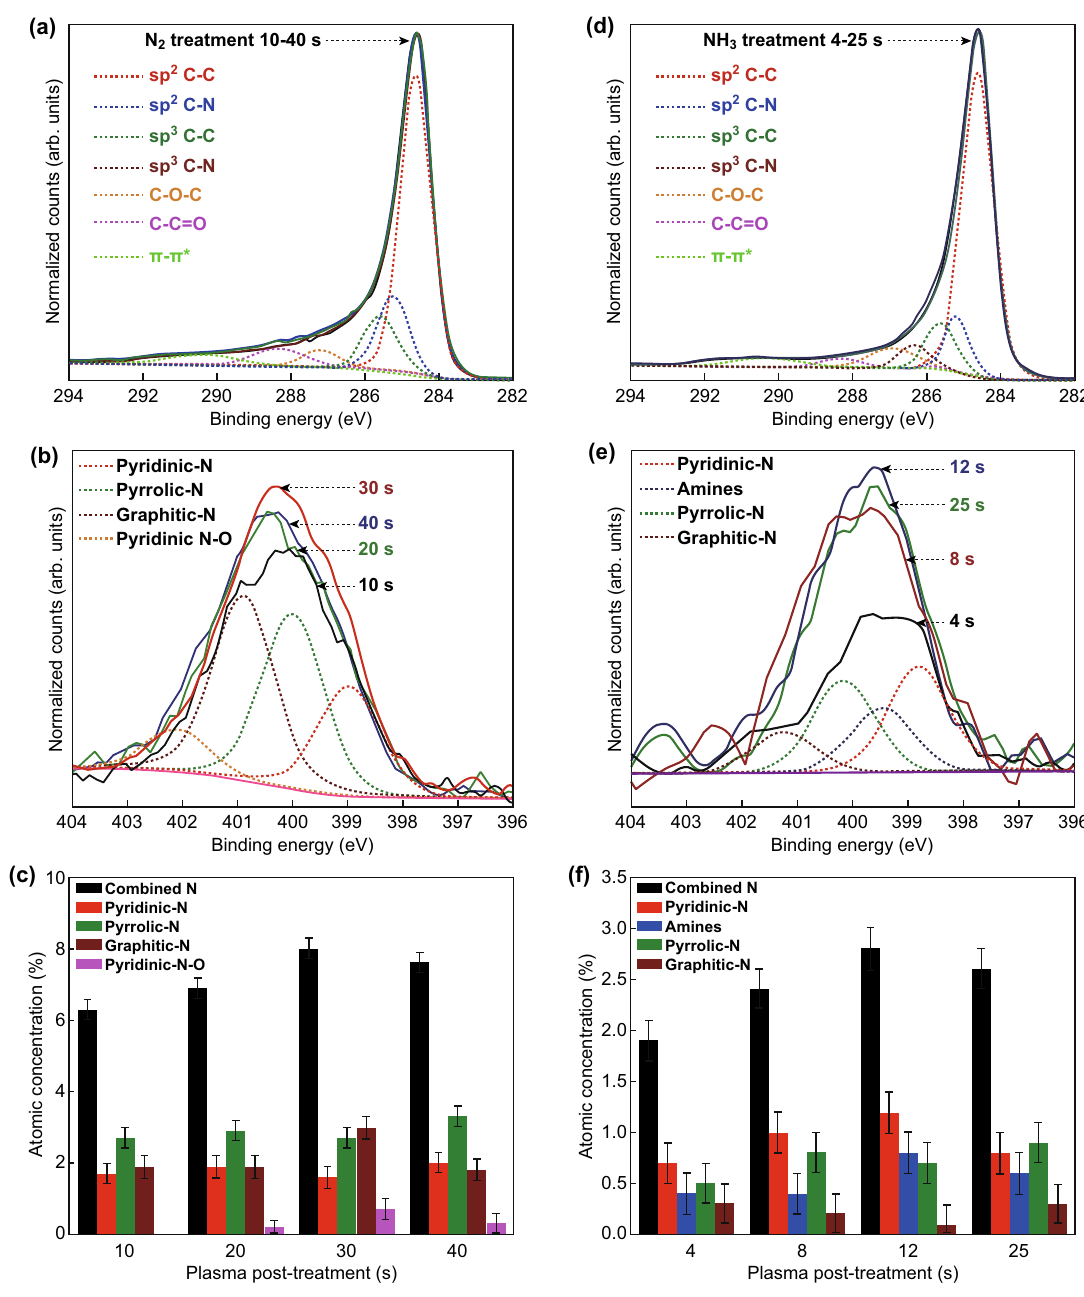
Fig. 4 a High-resolution C 1s spectra, b N 1s spectra, and c content distributions of nitrogen configurations after N 2 plasma post-treatment. d High-resolution C 1s spectra, e N 1s spectra and f content distributions of nitrogen configurations after NH 3 plasma